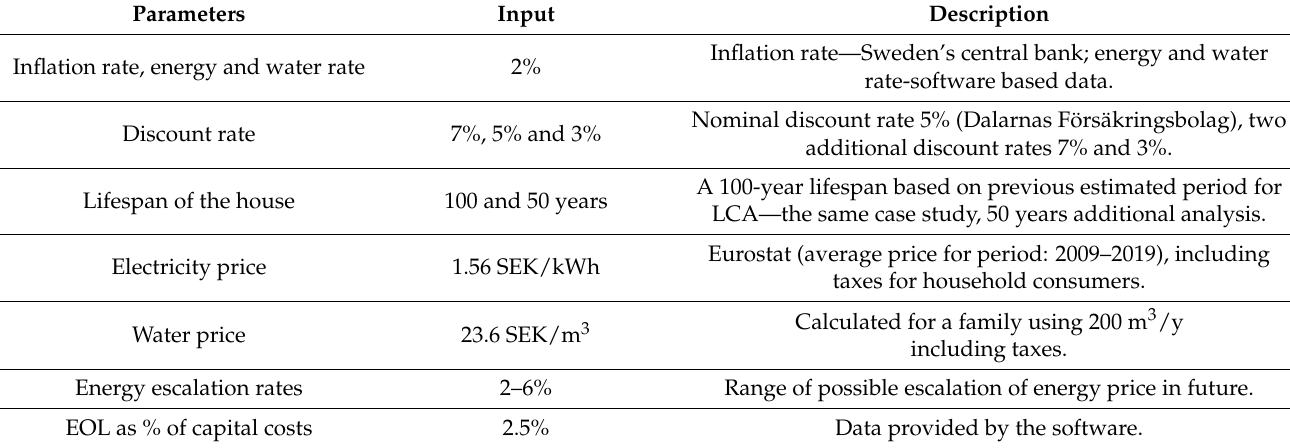
Table 2. Economic parameters used in